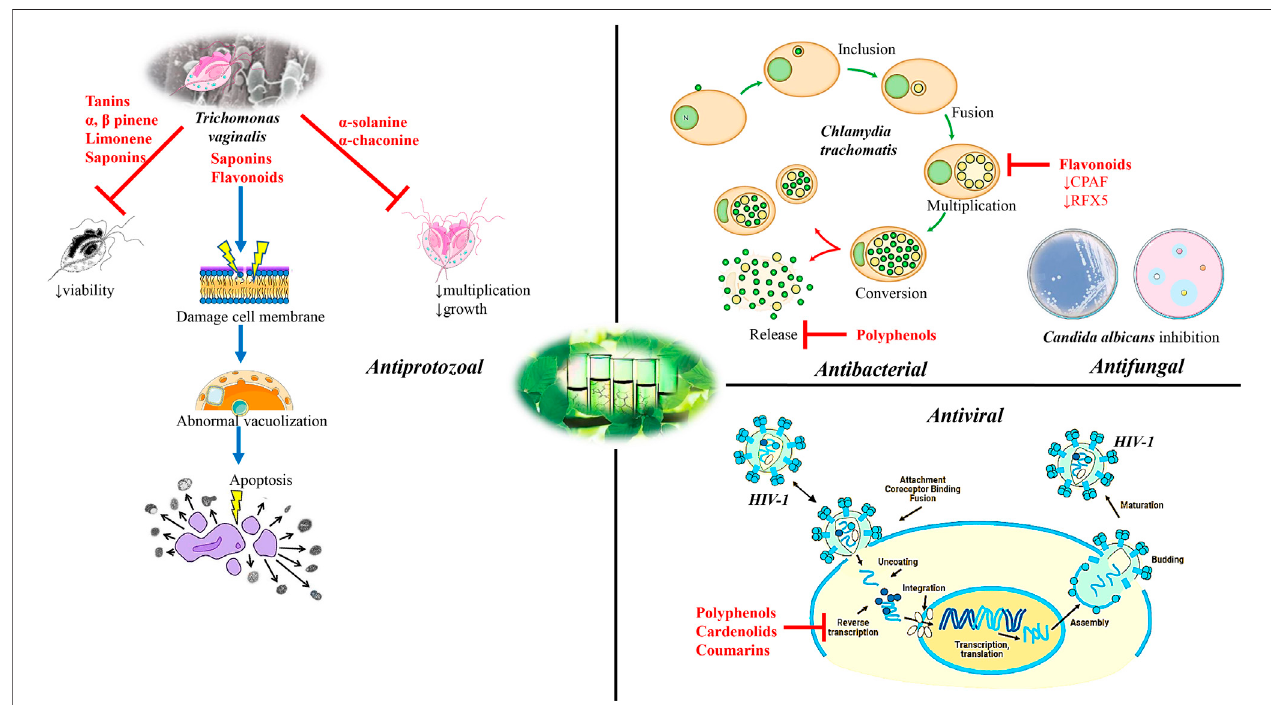
FIGURE 3 | Diagram with the most important molecular mechanisms and targets of natural bioactive compounds as potential alternative agents of STDs. Abbreviations and symbols: ↑ increased, ⊥ inhibition, chlamydial protease-like activity factor (CPAF), regulatory factor X-5 (RFX5), human immunode fi ciency virus type 1 (HIV-1)